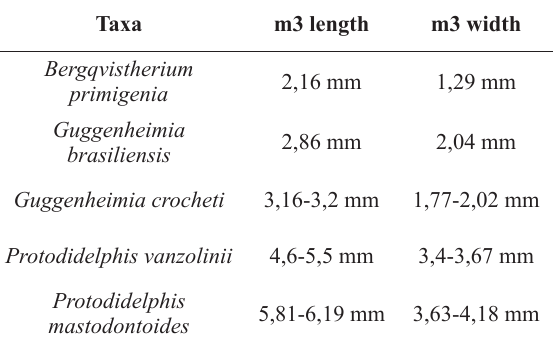
Measurements (mm) of the third lower molars (m3) of Bergqvistherium primigenia gen. et sp. nov and other protodidelphids. The size range of known specimens is indicated and based on the specimens from the Museu Nacional (MN), Rio de Janeiro; Museu de